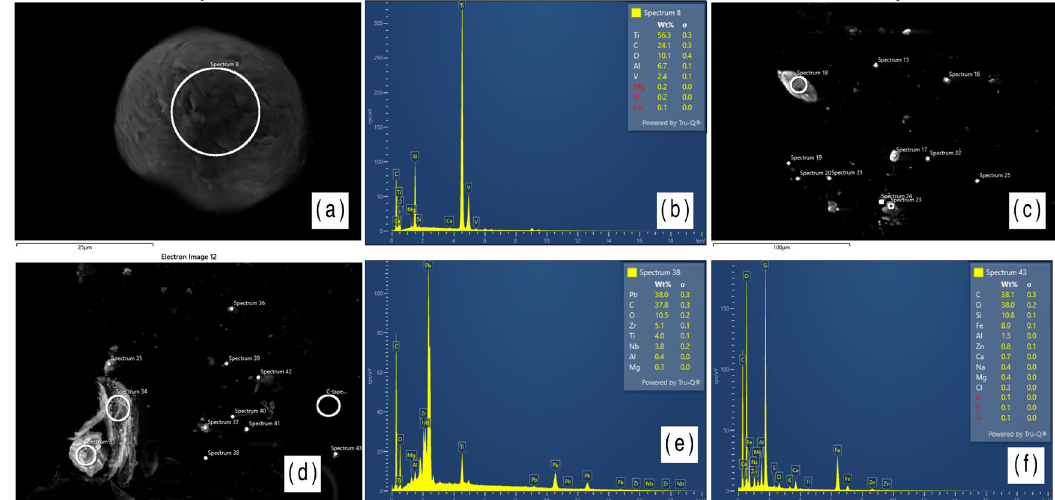
Fig. 7 SEM and EDS values post-treatment for the FW-Al experiment paramagnetic sediment. a Shows the nano-sphere of titanium- vanadium b is the EDS spectrum of the nano-sphere. c Is the overview SEM image of sediment on carbon tray d is the overview SEM image of sediment group 2 on the carbon try. e Shows the spectrum analysis of specimen 34 ( f ) while depicts the spectrum analysis of specimen 43.